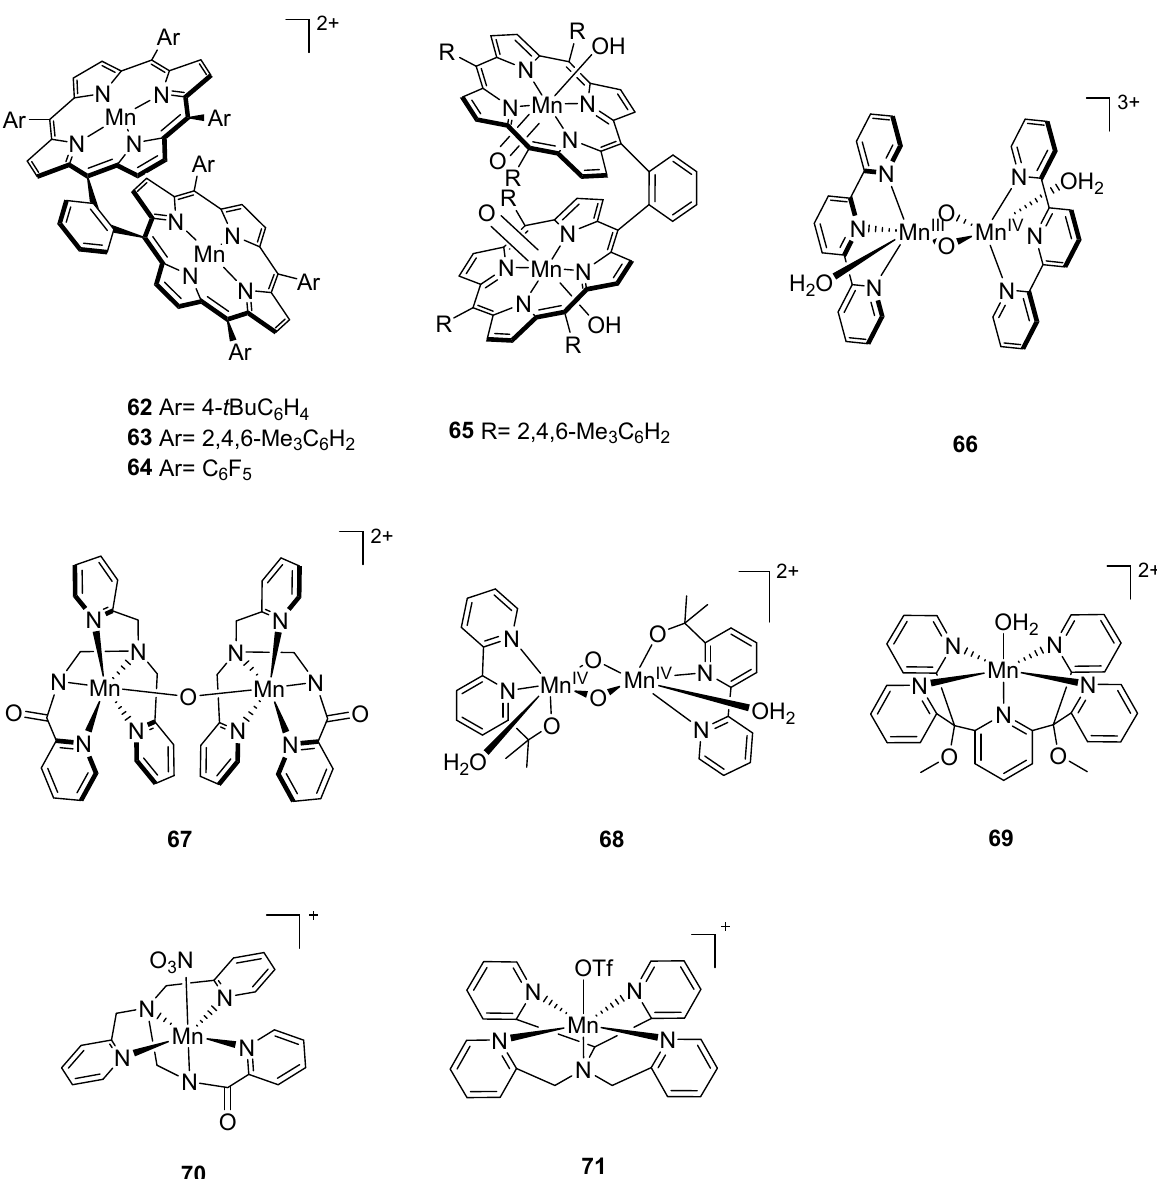
Figure 6. Chemical structures of selected manganese catalysts 62–71 for water oxidation: [Mn 2 ( μ - o -xyl)( t BuPP) 2 ] 2+ ( 62 , t BuPP = 5,l0,15,20-tetrakis(4- tert -butylphenyl)-21 H ,23 H -porphin) [133]; [Mn 2 ( μ - o -xyl)(TMP) 2 ] 2+ ( 63 , TMP = 5,l0,15,20- tetrakis(2,4,6-trimethylphenyl)-21 H ,23 H -porphin) [133]; [Mn 2 ( μ - o -xyl)(PFPP) 2 ] 2+ ( 64 , PFPP = 5,l0,15,20-tetrakis(pentafluor- ophenyl)-21 H ,23 H -porphin) [133]; [Mn V2 ( μ - o -xyl)(TMP) 2 (OH) 2 (O) 2 ] 2+ ( 65 , TMP = 5,l0,15,20-tetrakis(2,4,6-trimethylphenyl)- 21 H ,23 H -porphin) [134]; [Mn III/IV2 ( μ -O) 2 (terpy) 2 (H 2 O) 2 ] 3+ ( 66 , terpy = 2,2 ′ :6 ′ ,2”-terpyridine) [138,139]; [Mn((PaPy 3 )( μ - O)(PaPy 3 )Mn] 2+ ( 67 , PaPy 3 H = N,N -bis(2-pyridylmethyl)-amine- N -ethyl-2-pyridine-2-carboxamide) [141]; [Mn IV (bipyalk) 2 (H 2 O) 2 ( μ -O) 2 ] 2+ ( 68 , bipyalk = 2-([2,2 ′ -bipyridin])-6-yl)propan-2-olate) [142]; [Mn(PY5)(OH 2 )] 2+ ( 69 , PY5 = 2,6-bis(bis(2-pyridyl)methoxymethane)- pyridine) [141]; [Mn(PaPy 3 )(NO 3 )] + ( 70 , PaPy 3 H = N,N -bis(2-pyridylmethyl)- amine- N -ethyl-2-pyridine-2-carboxamide) [141]; [Mn(N4Py)OTf] + ( 71 , N4Py = N,N -bis(2-pyridyl- methyl)- N -bis(2- pyridyl)methylamine) [141].